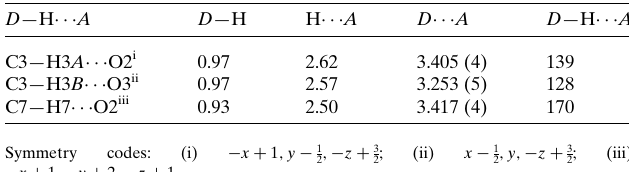
Table 1 Hydrogen-bond geometry (A˚ , (cid:2) ) for 1 .